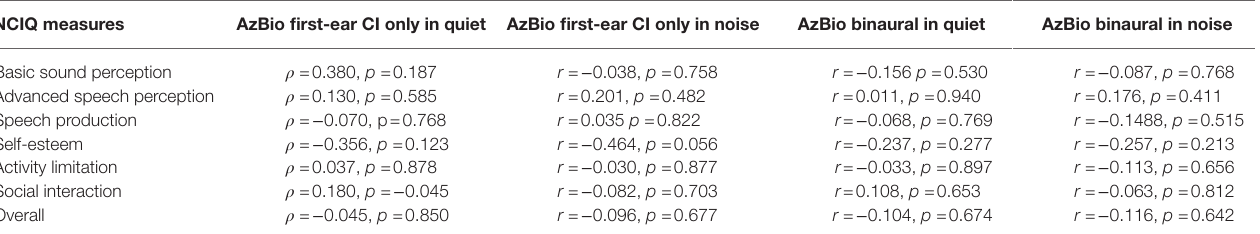
TABLE 4 | Relationships between AzBio and NCIQ scores.